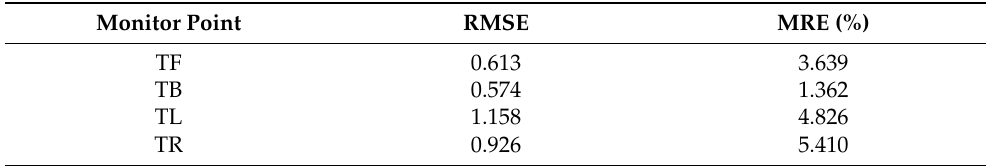
Table 2. Comparison between the simulation values and the experiment value of the temperature of fresh tea leaves in the